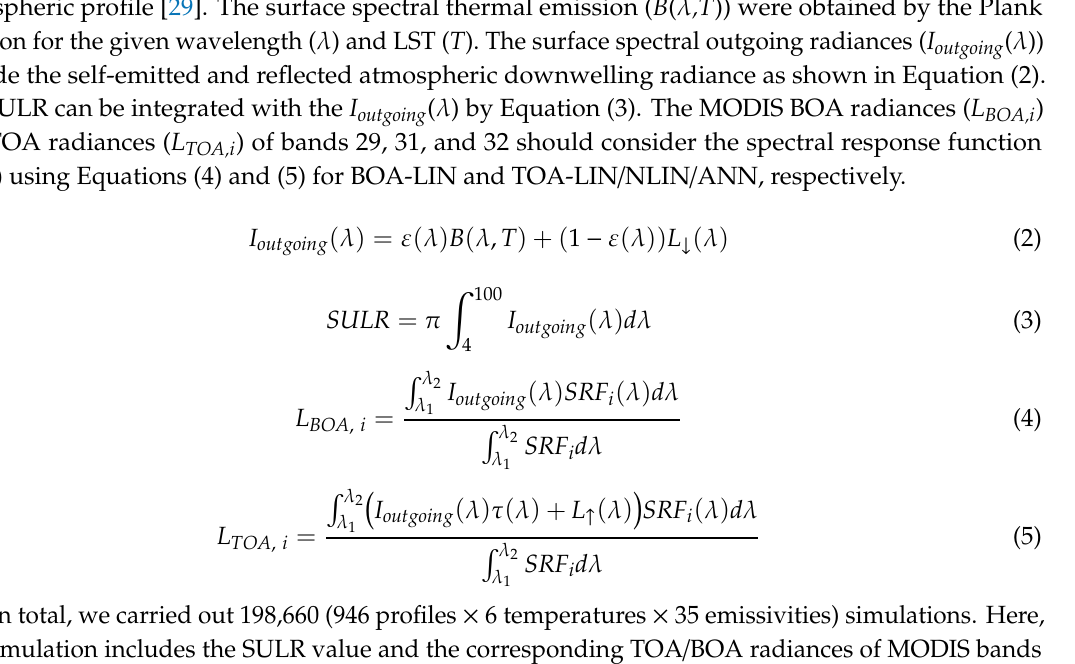
temperature-emissivity methods (TE-MYD21 and TE-MYD11) and the clear-sky TOA radiances, and the coe ffi cients of TOA methods were used to drive the TOA hybrid methods (TOA-LIN, TOA-NLIN, and TOA-ANN). The data processing for the BOA-LIN method includes four steps: (1) Extracting the atmospheric profiles form ERA5 global reanalysis product based on geolocation (latitude and longitude) and the Shuttle Radar Topography Mission (SRTM) digital evaluation model (DEM) [30]; (2) calculating the atmospheric parameters ( τ , L ↓ and L ↑ ) using ERA5 atmospheric profiles; (3) performing the atmospheric correction from clear-sky TOA radiances to BOA radiances using the atmospheric parameters; (4) calculating the SULR using the BOA radiances with BOA coe ffi cients. Finally, the six methods were evaluated using the SURFRAD SULR in situ